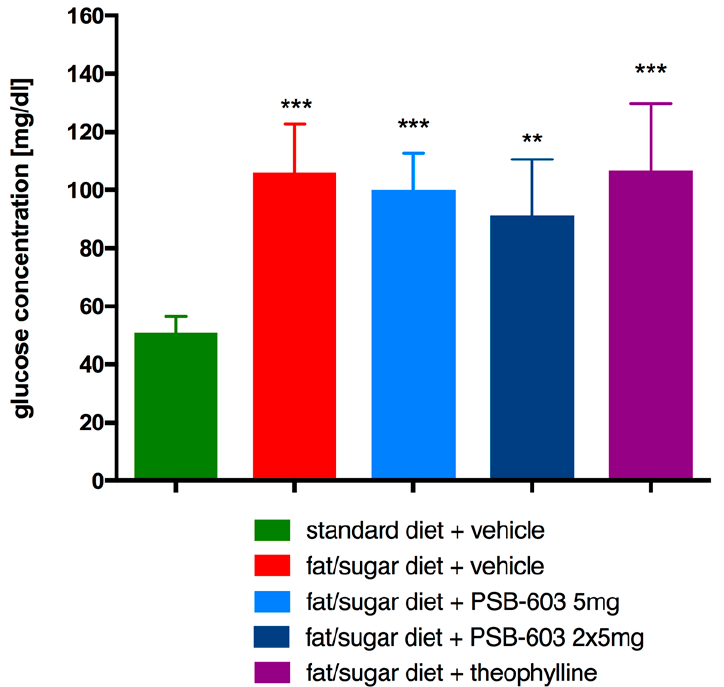
Figure 6. Effect of PSB-603 or theophylline administration on the plasma glucose level. Results are expressed as means ± SD, n = 6–9. Comparisons were performed by one-way ANOVA Tukey post hoc; * significant compared to control mice fed standard diet; ** p < 0.01, *** p < 0.001.